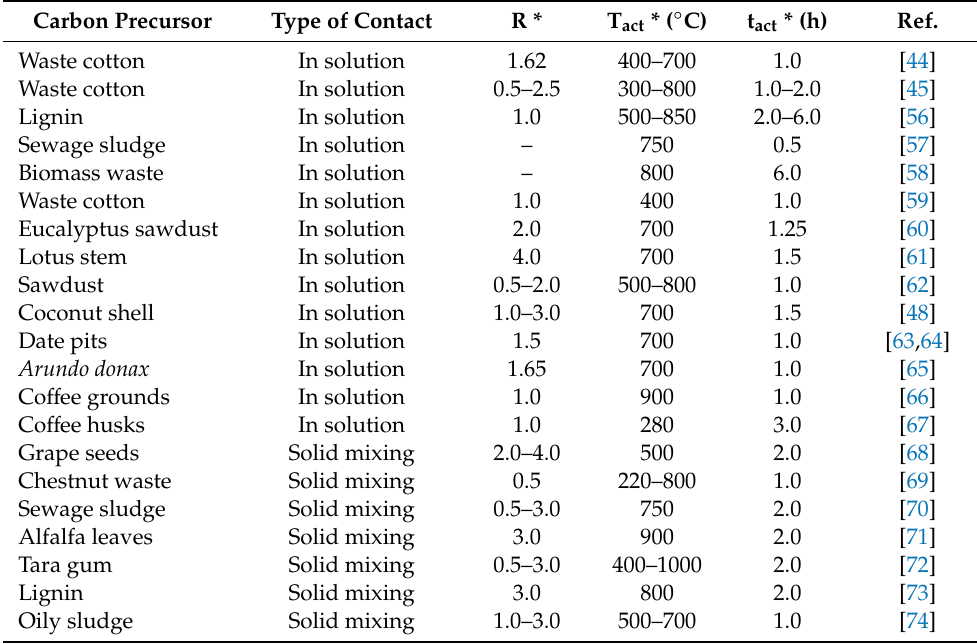
Table 1. Summary of FeCl 3 activation